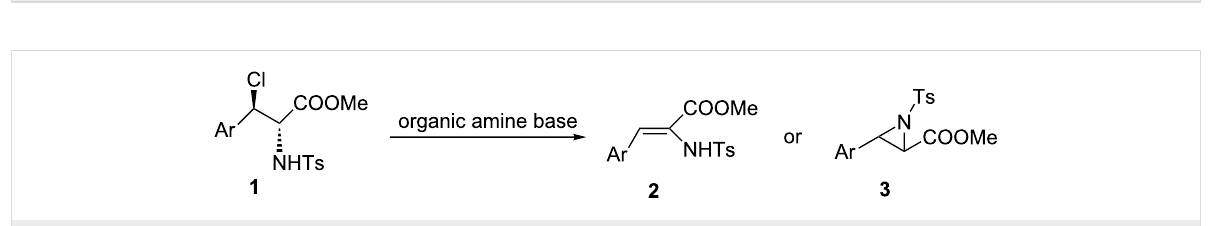
Scheme 2: Transformation of vicinal haloamines by the use of organic